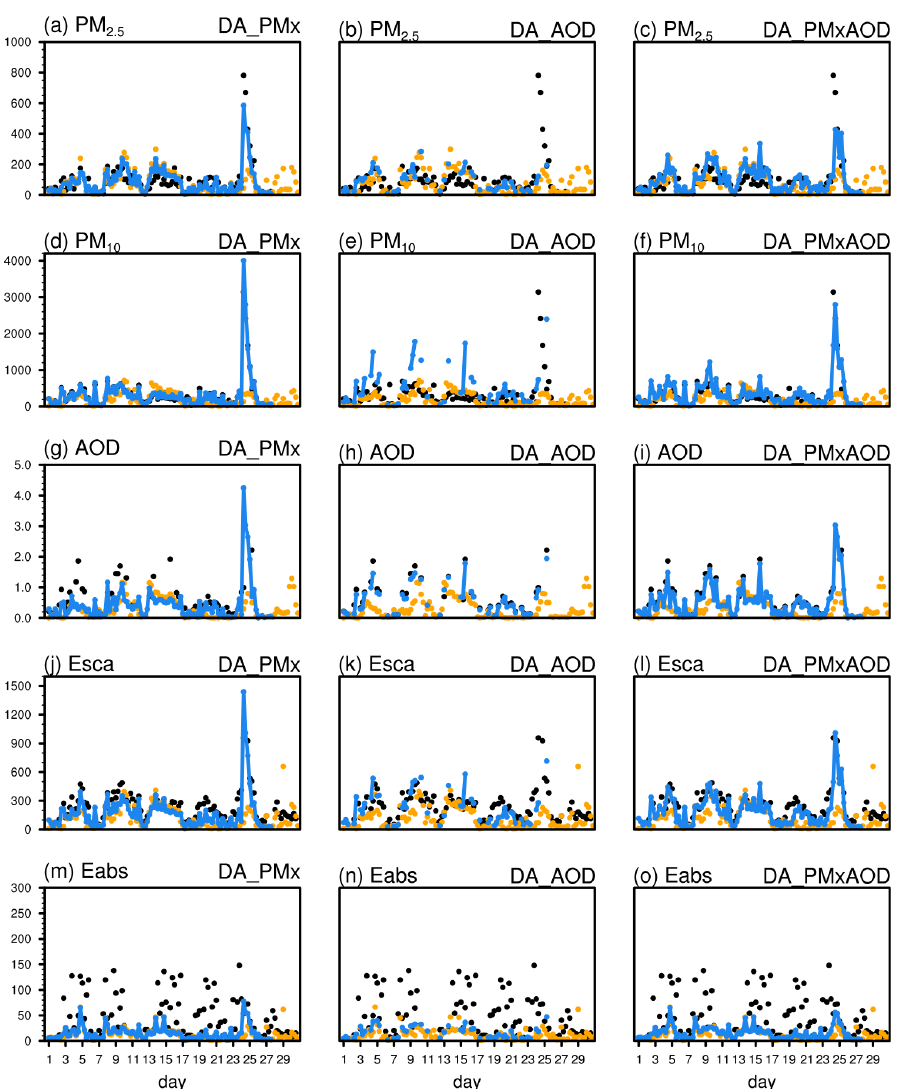
Figure 6. Comparison of PM 2 . 5 (µgm − 3 ; a – c ), PM 10 (µgm − 3 ; d – f ), 870nm AOD (g–i) , 635nm aerosol scattering coefficient (Esca, Mm − 1 ; j – l ), and 660nm aerosol absorption coefficient (Eabs, Mm − 1 ; m – o ) in the observation (black solid points), the background simulation (orange solid points), and the DA analyses (blue line) when assimilating the observed PM 2 . 5 and PM 10 (DA_PM x ), AOD (DA_AOD), and simultaneously assimilating PM x and AOD (DA_PMxAOD) at Kashi in April